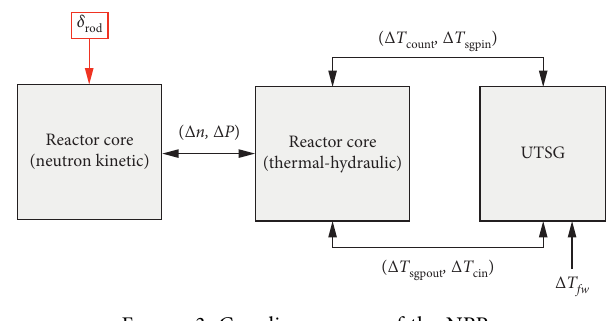
Figure 3: Coupling process of the